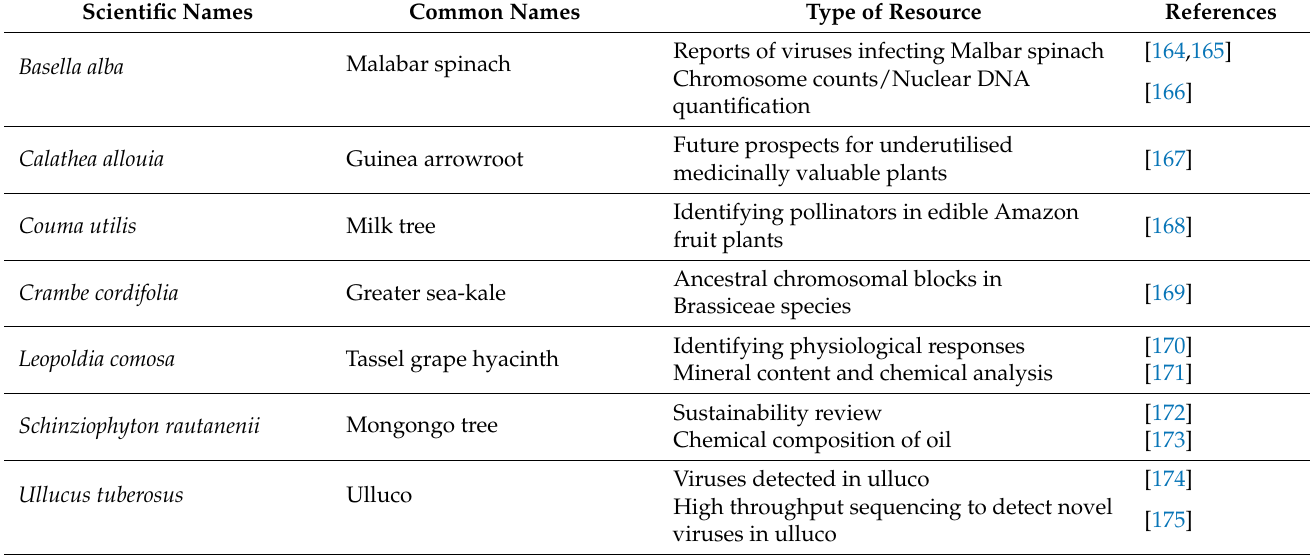
Table 2. Research involving underutilised crops without genomic references.